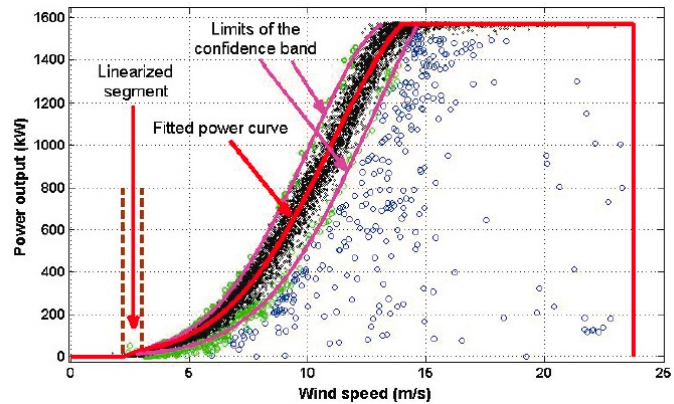
Figure 8. Confidence band for the power curve. Curve data: black; Data used to estimate the confidence band: green; Data anomalies: blue.